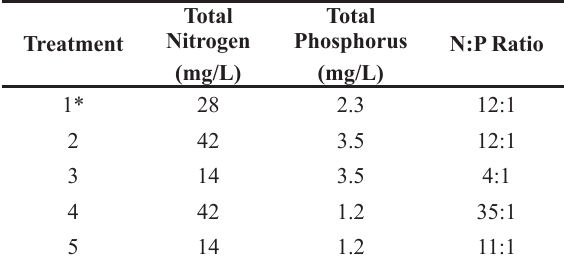
Changes in nitrogen and phosphorus concentrations of the ASM-1 culture medium.